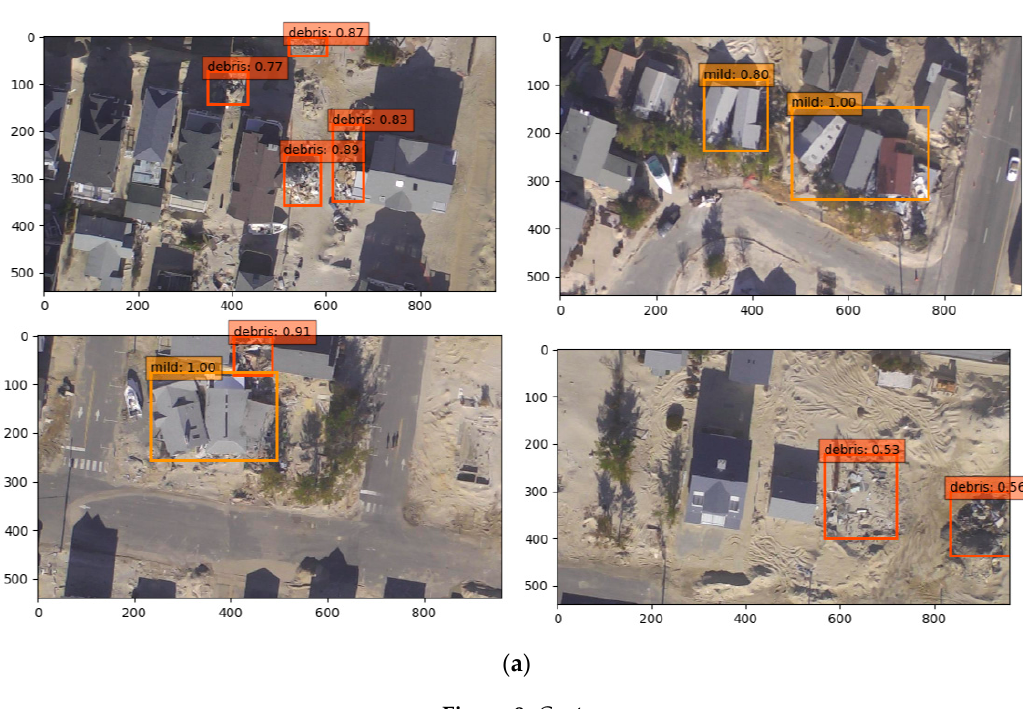
Table 5. The results of the data augmentation method in the test dataset.